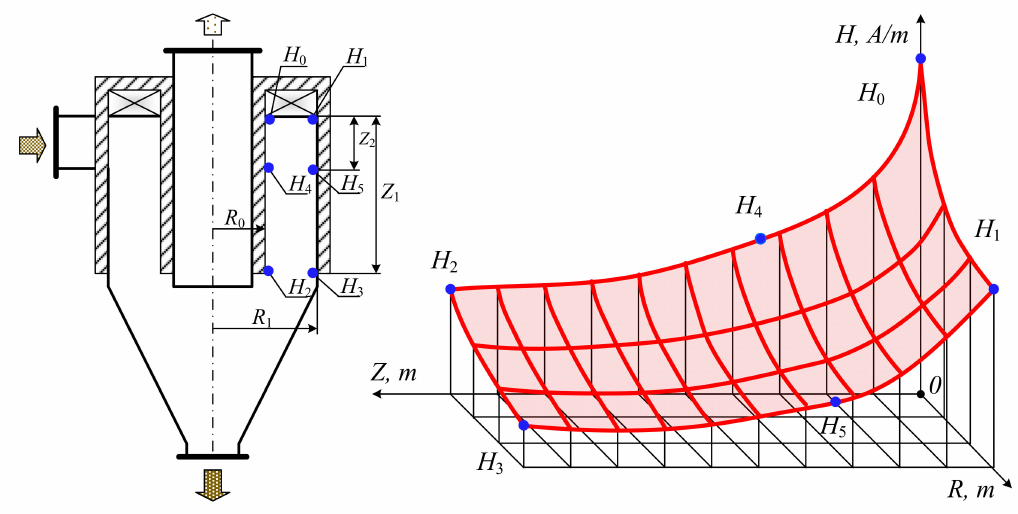
Figure 6. The changes in the magnetic field strength in the hydrocyclone working